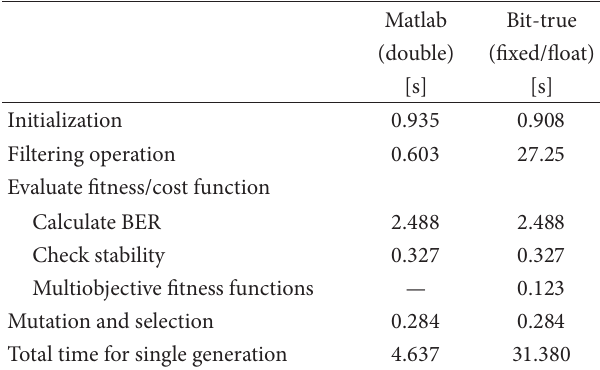
Table 4: Execution time analysis of a single generation of the DE1 algorithm (population size: 100